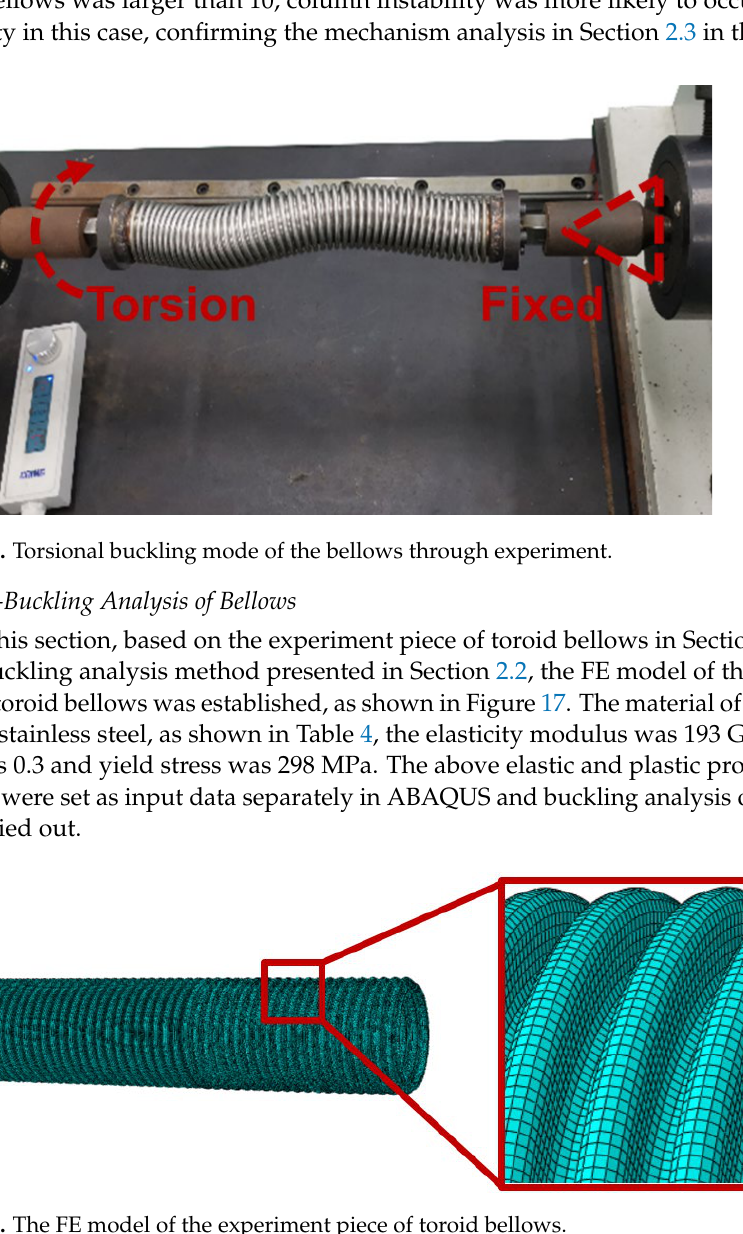
Figure 17. The FE model of the experiment piece of toroid bellows.